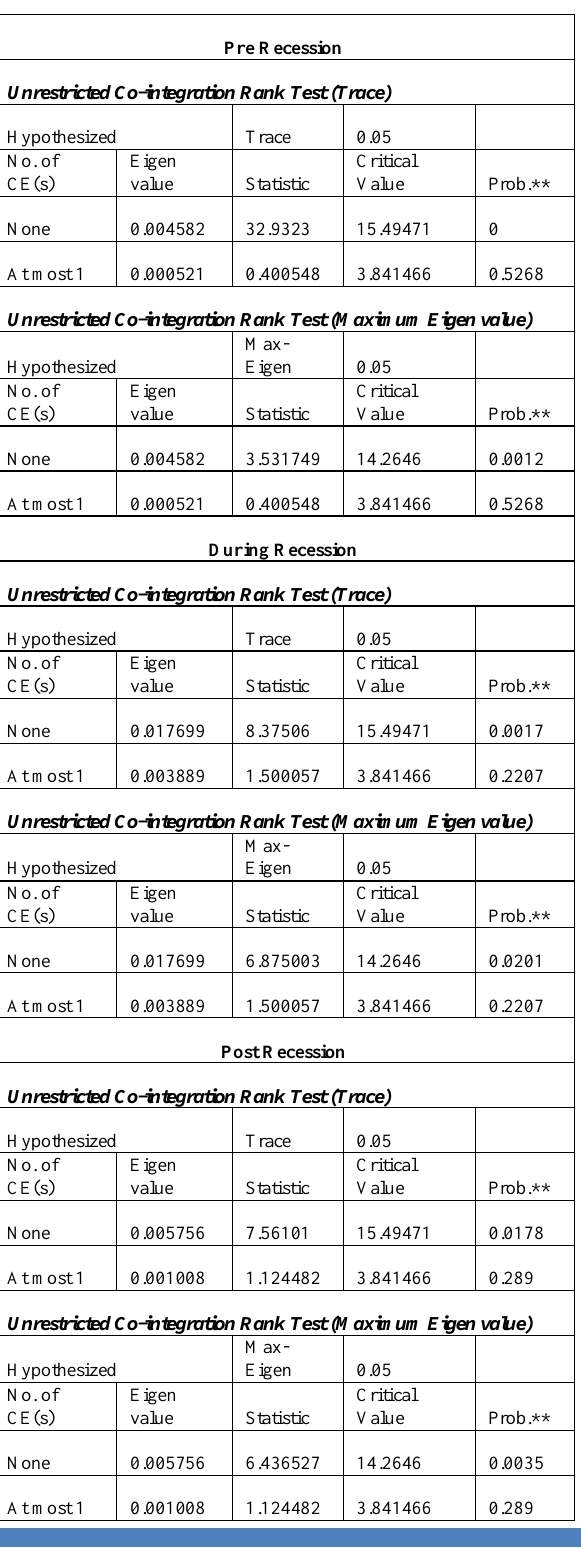
Table 3: The Results of Johansen Co-Integration Test Between Gold USD Exchange Rate